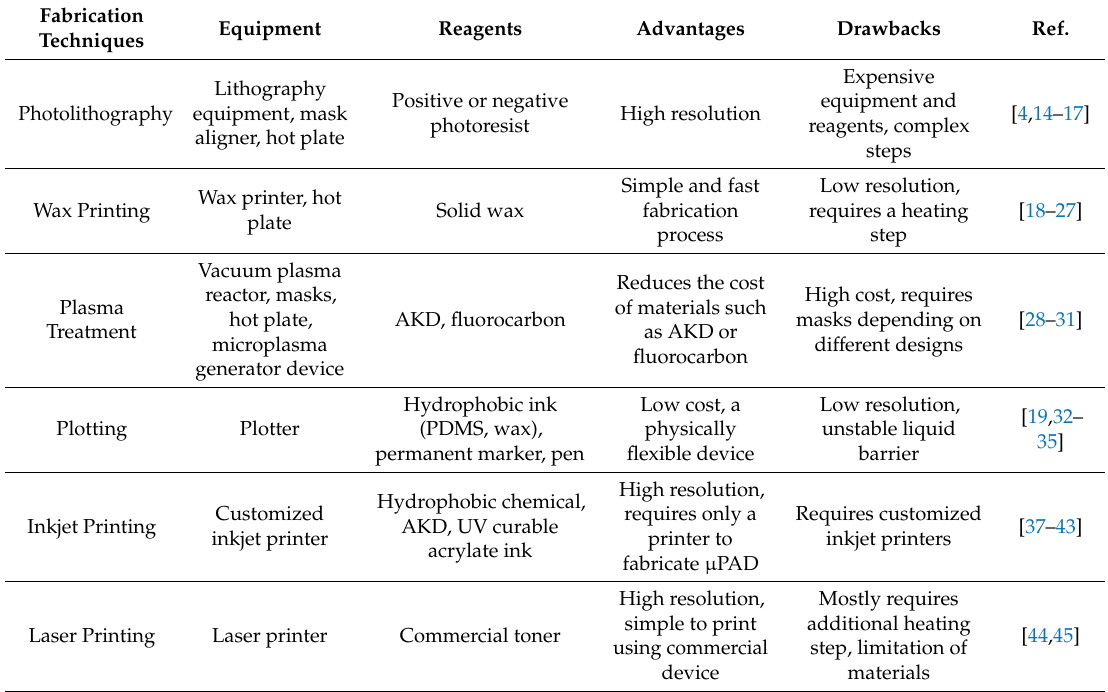
Table 1. Summary of fabrication techniques for creating microfluidic paper-based analytical devices. Fabrication Techniques